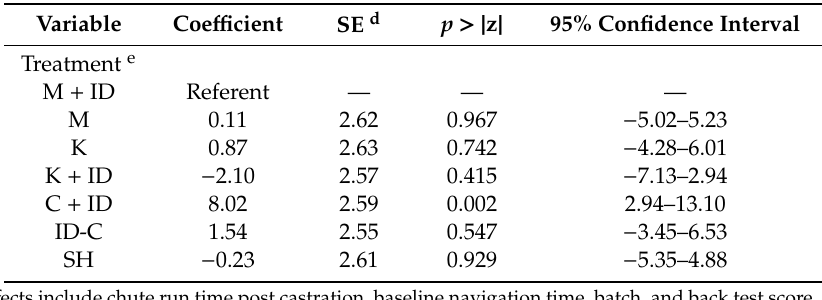
Table 2. Overall navigation time (seconds) by treatment group using meloxicam and iron dextran (M + ID) treatment group as the referent category, accounting for additional fixed a and random b e ff ects (model 1) c .